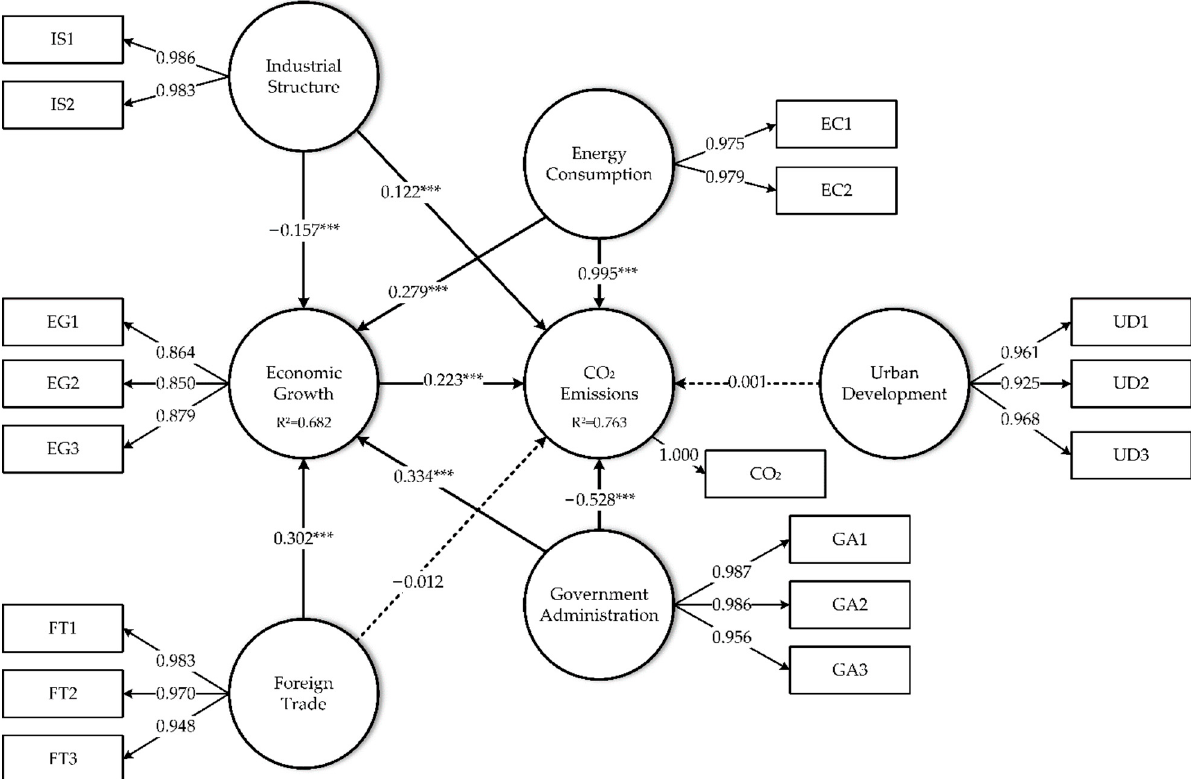
Figure 6. Results of PLS-SEM. Note: The dotted line indicates that the path fails the hypothesis test, and the solid line indicates that the path passes the hypothesis test. *** p < 0.001.